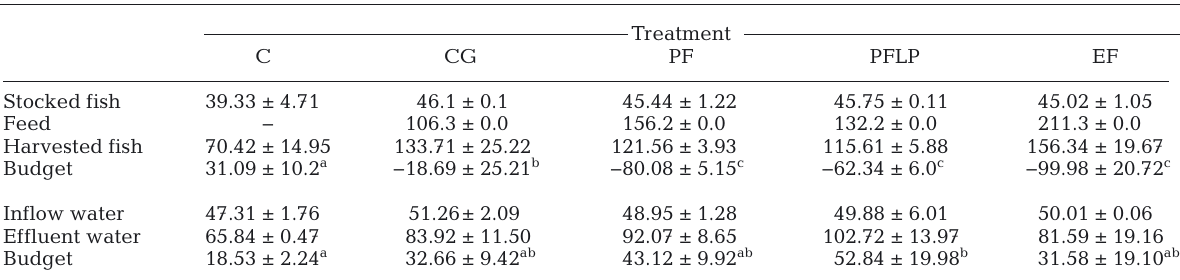
Table 5. Mean (±SD) phosphorus budget (g) for carp Cyprinus carpio yield and for inflow and effluent water under different treatments (see Fig. 1) per experimental storage pond. Superscripts a, b and c represent outcomes from the non-parametric multiple comparison test (Kruskal−Wallis and multiple comparison test). Mean values in the same row with different super- scripts differ significantly (p <